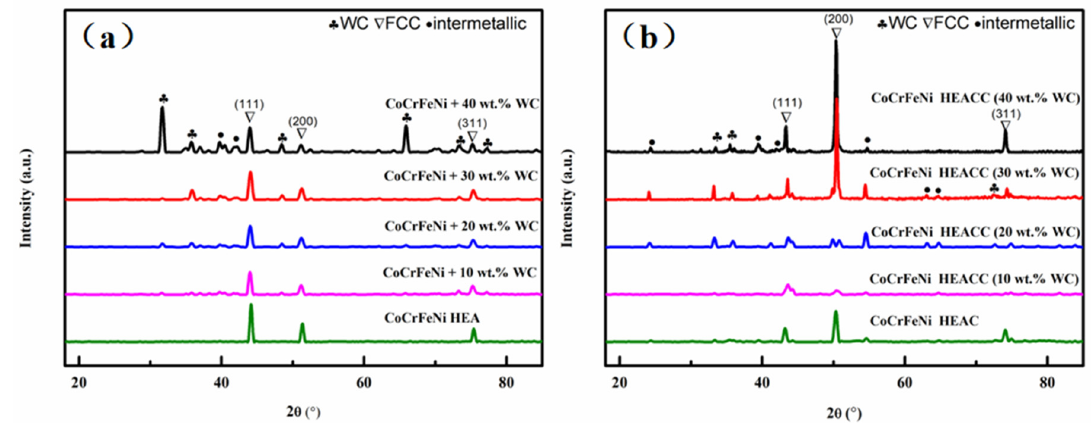
Figure 3. XRD patterns: ( a ) mixed powders; ( b ) CoCrFeNi HEACC. Table 4. Crystallite size (D) and lattice constant (a) of the FCC phase (111) peak in coatings.